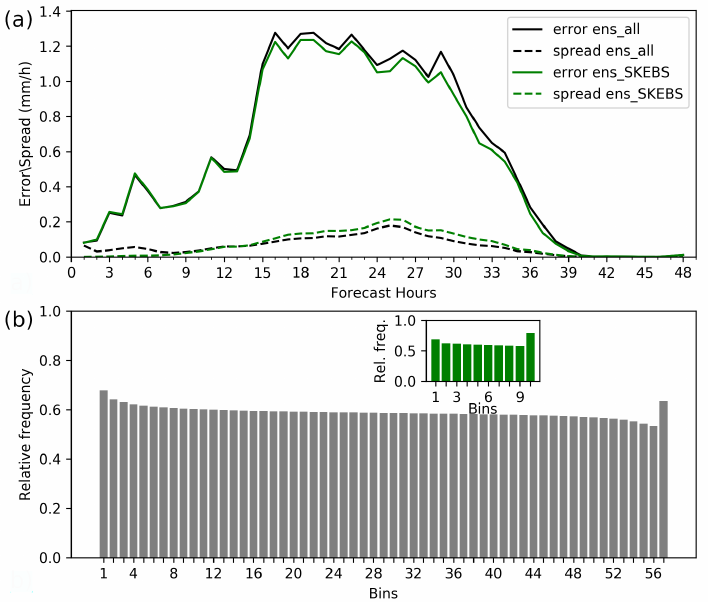
Figure 13. ( a ) the spread-skill diagram and ( b ) the rank histogram plot for precipitation using hourly IMERG data as observations for the WRF domain. Black lines and bars correspond to the overall ensemble, while the green ones are for the ensemble considering Stochastic Kinetic Energy Backscatter parameterization (SKEBS) members only. Valid for the simulation period starting at 00Z on 27 February